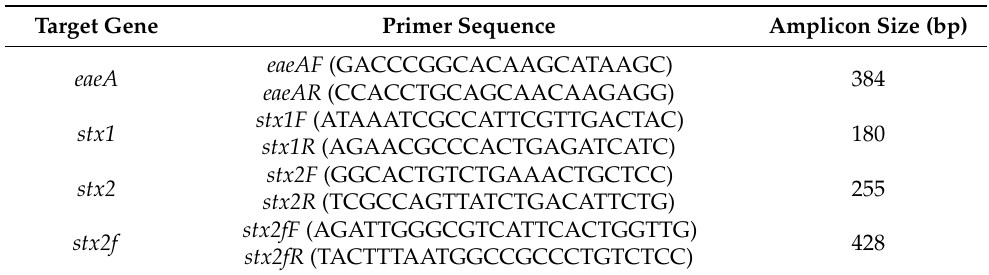
Table 1. Shiga toxin producing E. coli (STEC) target genes, their primer sequences and amplification fragment sizes for multiplex PCR reaction method developed by EU Reference Laboratory for E. coli (EURL-VTEC_Method_01_Rev 1) [48]. Target Gene Primer Sequence Amplicon Size (bp) eaeAF (GACCCGGCACAAGCATAAGC) eaeA eaeAR (CCACCTGCAGCAACAAGAGG) stx1 stx1R (AGAACGCCCACTGAGATCATC)